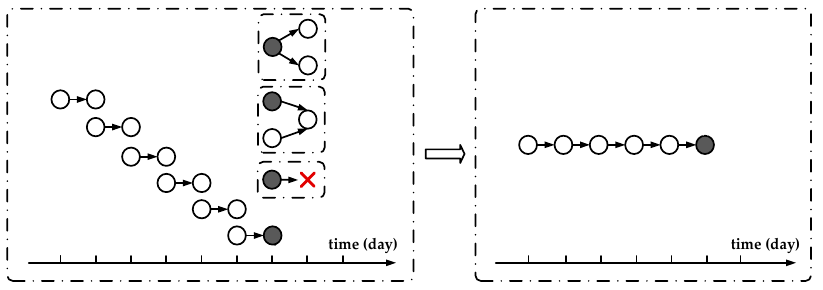
Figure 8. A diagram of tracking for a branch, where the state of the eddy branch on the last day (dark gray circle) of its life is split, merged or dead.